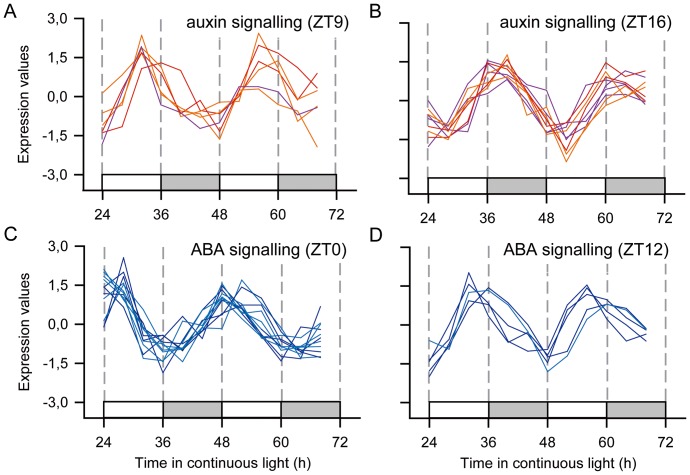
Rhythmic probes associated with auxin and ABA signalling.Z-score normalized time courses of rhythmic probes for transcripts associated with auxin and ABA signalling were separated into their approximated phase: (A) transcripts associated with auxin signalling peaking close to ZT9; (B) transcripts associated with auxin signalling peaking close to ZT16; (C) transcripts associated with ABA signalling peaking close to ZT0; and (D) transcripts associated with ABA signalling peaking close to ZT12. (A–B) Transcripts associated with auxin synthesis and reception (purple), ARF (orange), and Aux/IAA (red). (C–D) Transcripts associated with ABA synthesis and reception (dark blue) and transcripts associated with ABA response (blue). White boxes represent periods of subjective day and light grey boxes represent periods of subjective night.